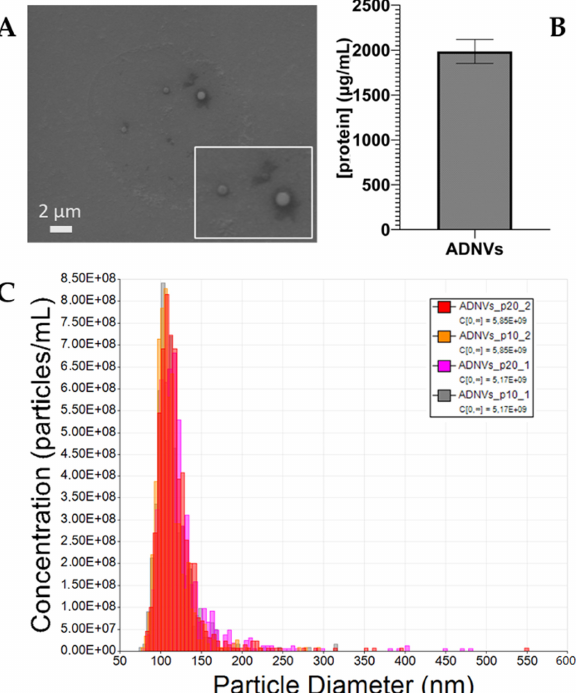
Figure 1. ( A ) SEM Imaging of ADNVs (MAG, 5.0 KX; WD, 15 mm; EHT, 15 kV; High Vacuum); ( B ) Protein quantification of the ADNV fraction after isolation ( μ g/mL); and ( C ) TRPS analysis output. Table 2. TRPS analysis data.